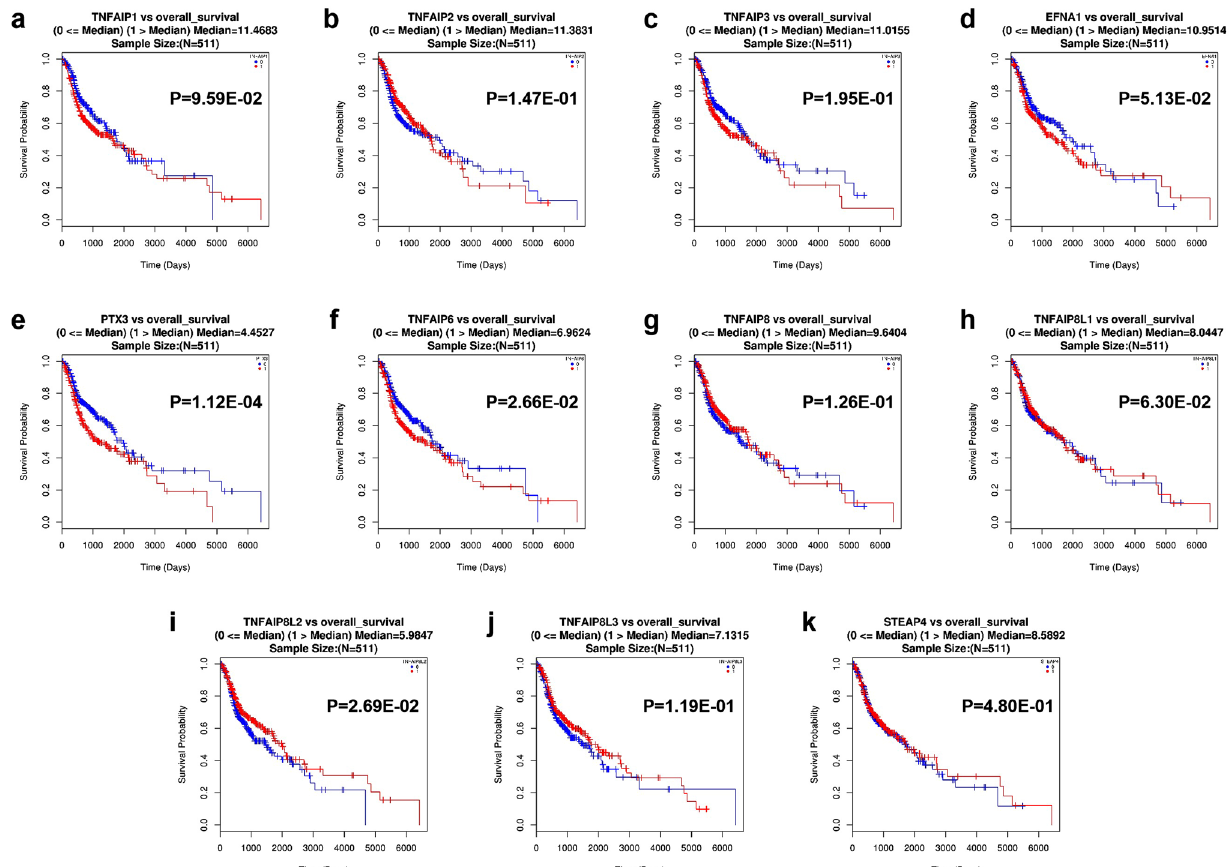
Figure 4. The prognostic value of TNFAIPs in HNC patients. The OS curves of HNC patients according to ( a ) TNFAIP1, ( b ) TNFAIP2, ( c ) TNFAIP3, ( d ) EFNA1, ( e ) PTX3, ( f ) TNFAIP6, ( g ) TNFAIP8, ( h ) TNFAIP8L1, ( i ) TNFAIP8L2, ( j ) TNFAIP8L3, and ( k ) STEAP4 expression